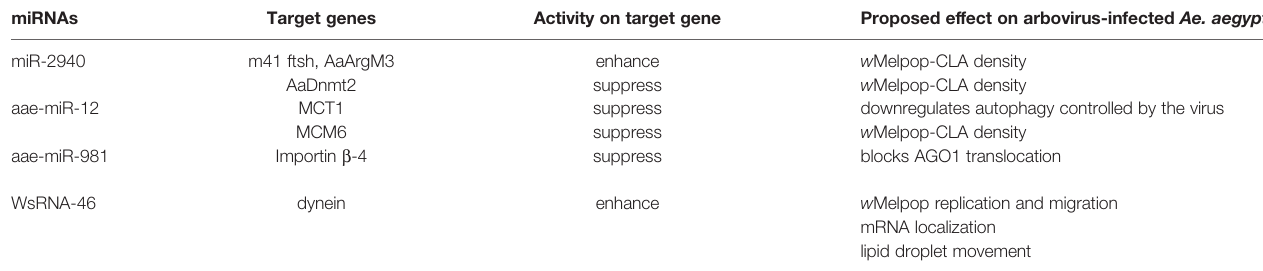
TABLE 2 | miRNAs induced by Wolbachia in Ae. aegypti